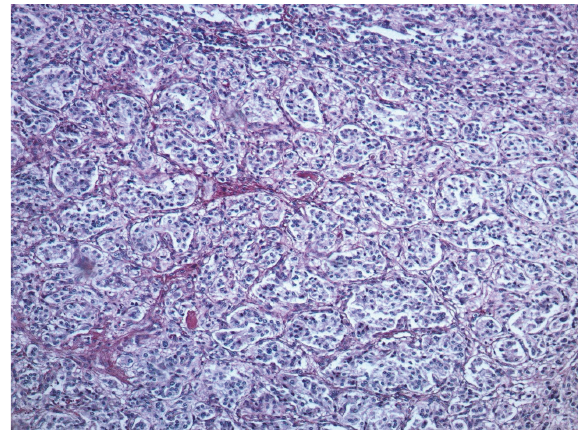
Figure 4: Pathology from left adrenal. Chromogranin (100x). Cytoplasmic granular staining diffusely positive in tumor cells.